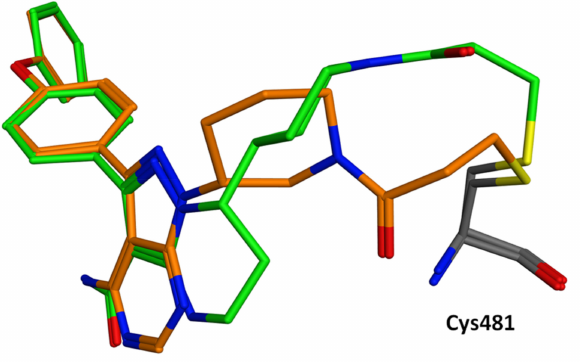
Figure 2. Superposition of Ibrutinib (orange, PDB code: 5P9J) and Zanubrutinib (green, PDB code: 6J6M) covalently bound to BTK